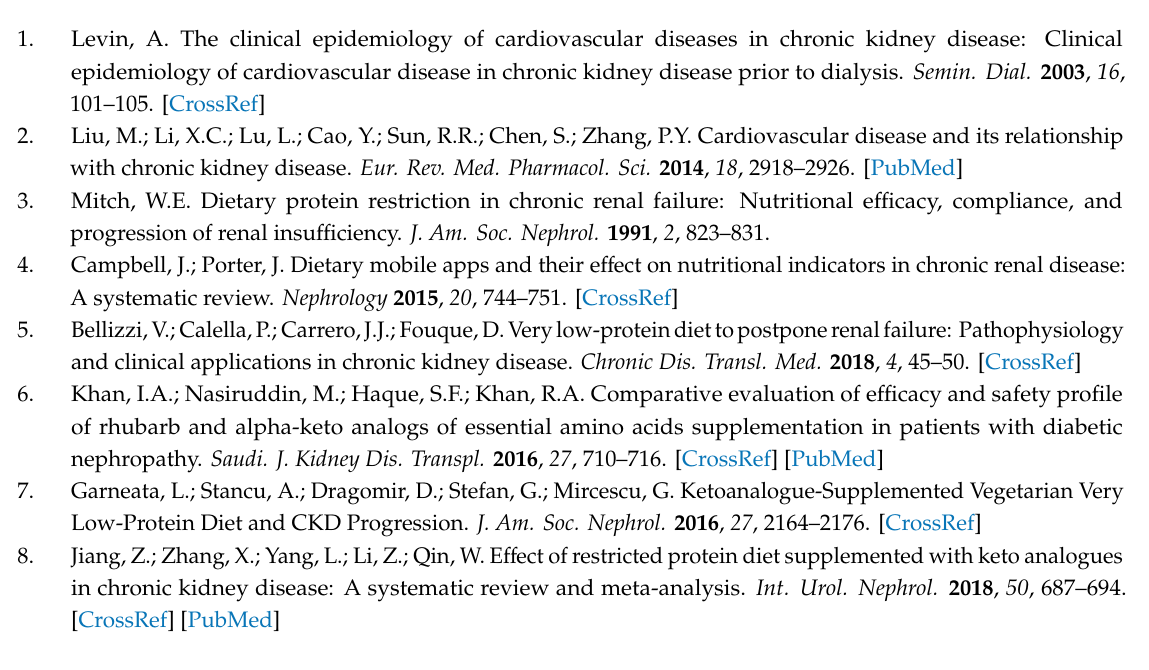
Table S1: The list of search terms on PubMed and